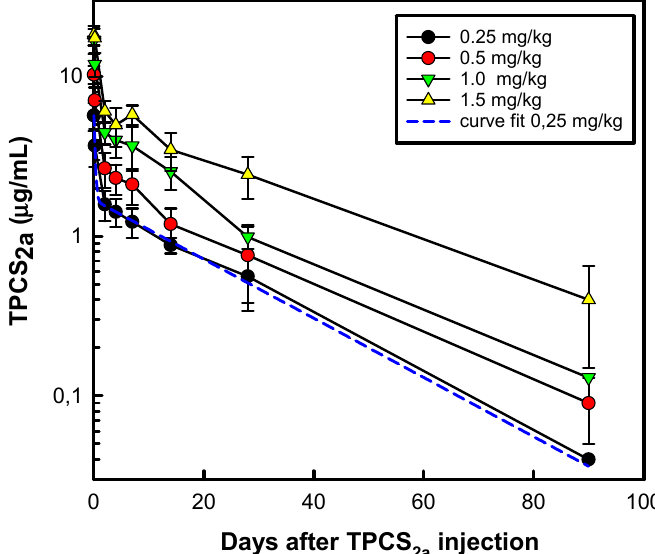
Figure 12. Pharmacokinetic analyses of plasma concentration of TPCS 2a . The concentration of TPCS 2a in plasma samples from patients in the dose cohorts 0.25–1.5 mg / kg was analyzed by fluorescence spectroscopy. The excretion rate of TPCS2a in the 0.25 mg / kg cohort that was regarded as the optimal treatment dose was found to fit well a two-compartment model: f ( x ) = 4.43e − 4.71 x + 1.69e − 0.69 x ( R 2 = 0.99) as presented in the figure. The figure is modified from previously presented results [106]. Error bars show SD.